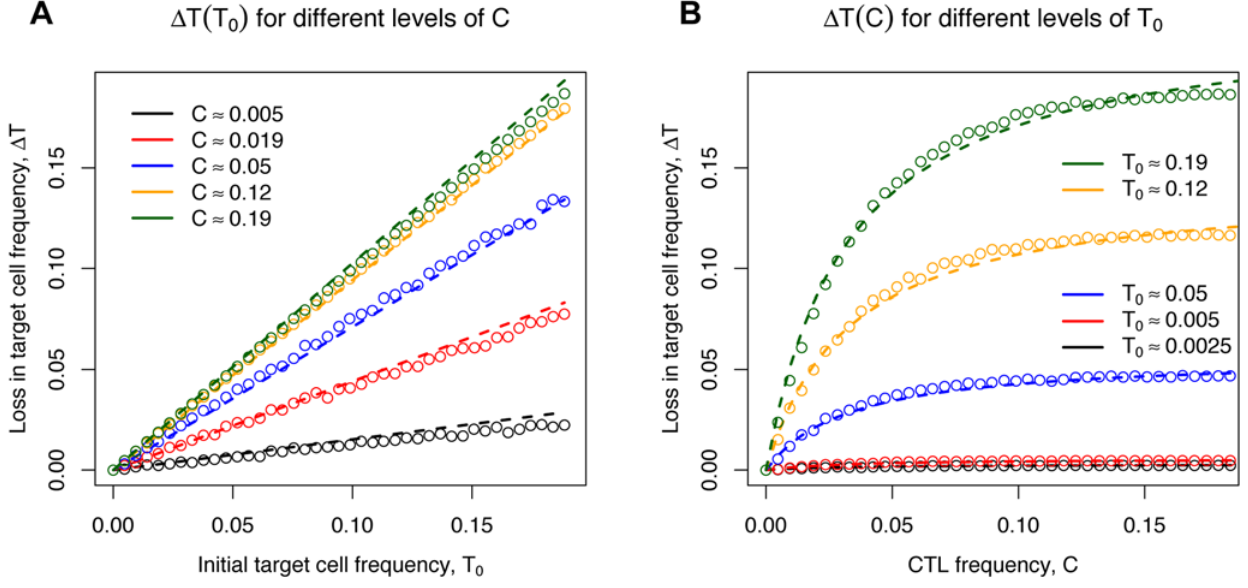
Figure 4. Change in the loss of target cell frequency, D T . The change in the loss of target cell frequency for different initial levels of target cells, T 0 , or CTL, C . D T is linear in T (shown in A) and not linear in C (shown in B). Added lines represent the fit of D T ~ k max CT = ( C z C 1 = 2 ) (dashed